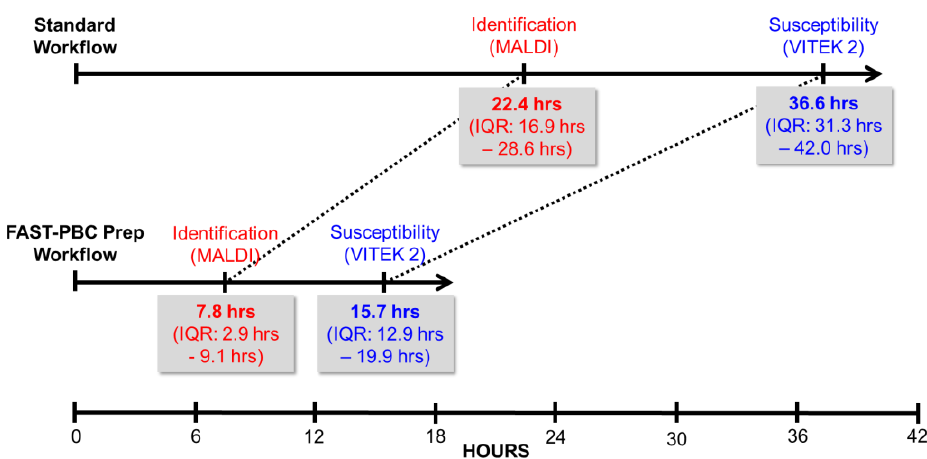
Figure 2. Timeline of microbiological procedures: median and interquartile range (IQR) of time from blood culture flagging positive to organism identification and phenotypic susceptibility results.